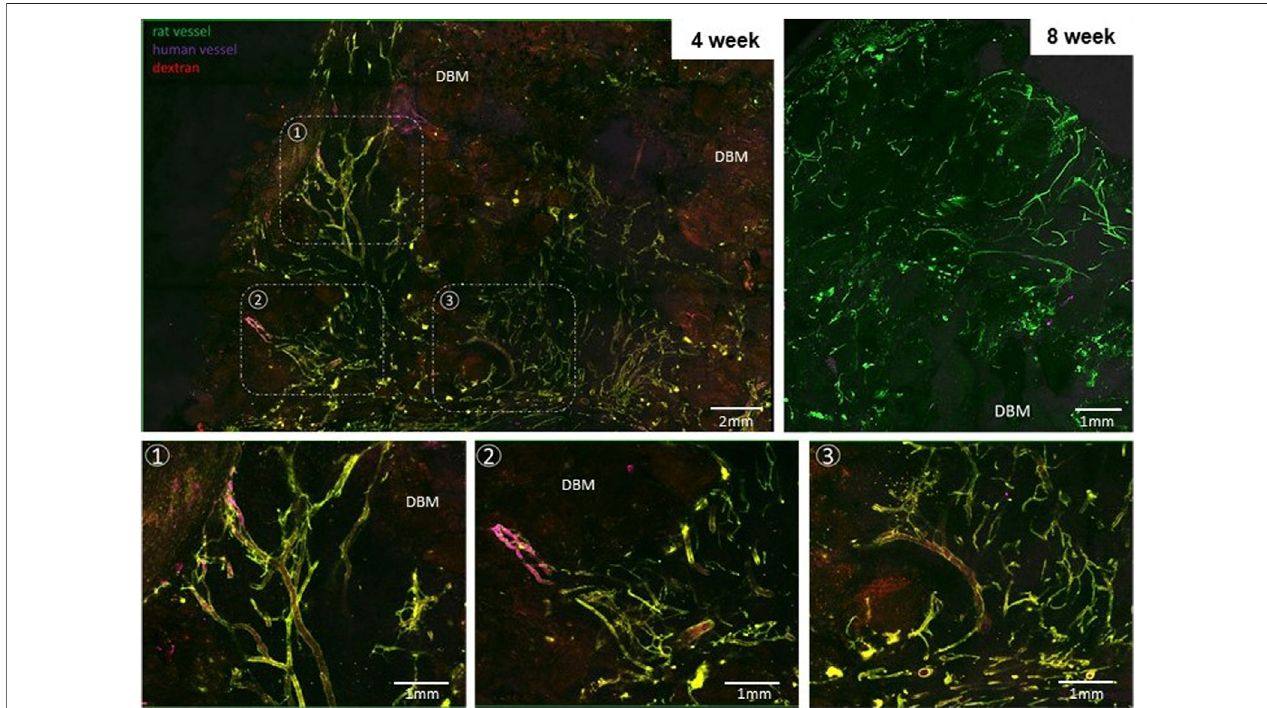
FIGURE 3 | Implants are well vascularized throughout the core. Projected, stitched confocal image stacks of en face preparations of explanted grafts at weeks 4 (graft681)and8(graft687).Bottomrow:Selectregionsfromthe fi rstpanelathighermagni fi cationhighlightingareasinvolvingperfusedhumanandrecipient(rat)vessels. Dextran was injected into the recipient circulation as a blood tracer in week 4 groups. Fluorescent UEA-1 lectin was used to stain the human microvasculature while fl uorescent GSL-1 lectin was used to stain the rodent vasculature. DBM = demineralized bone matrix.